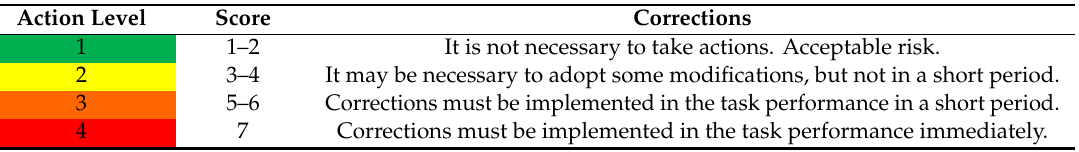
Table 2. RULA action levels (adapted from